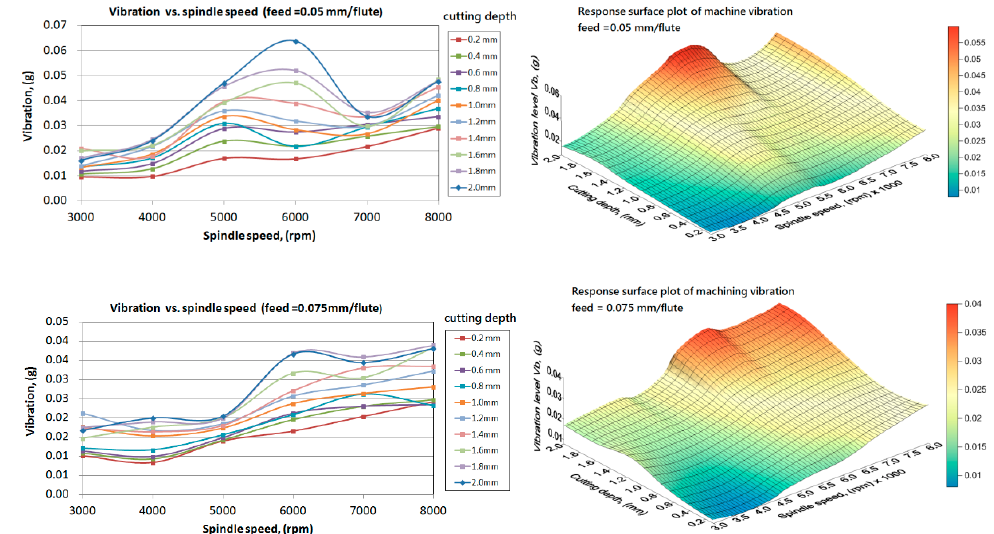
Figure 9. Variation of vibration levels with varying spindle speed and cutting depth at lower and higher feed rate, respectively.